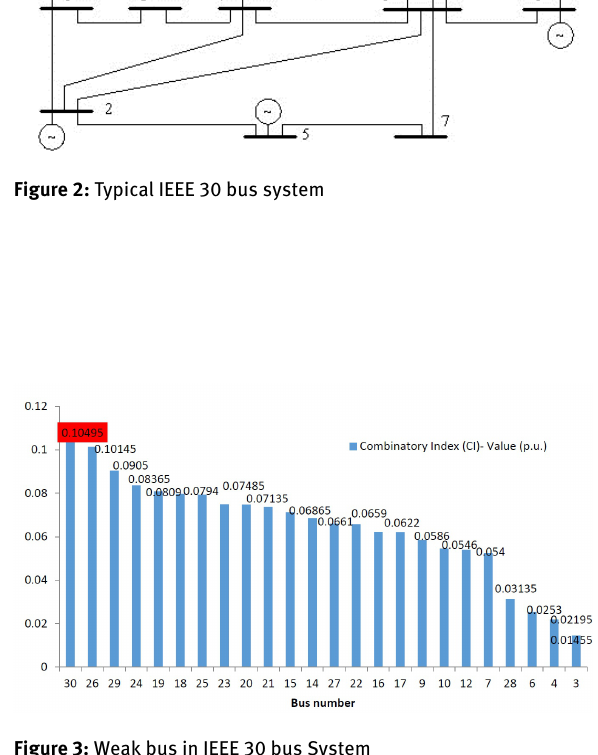
Figure 3: Weak bus in IEEE 30 bus System